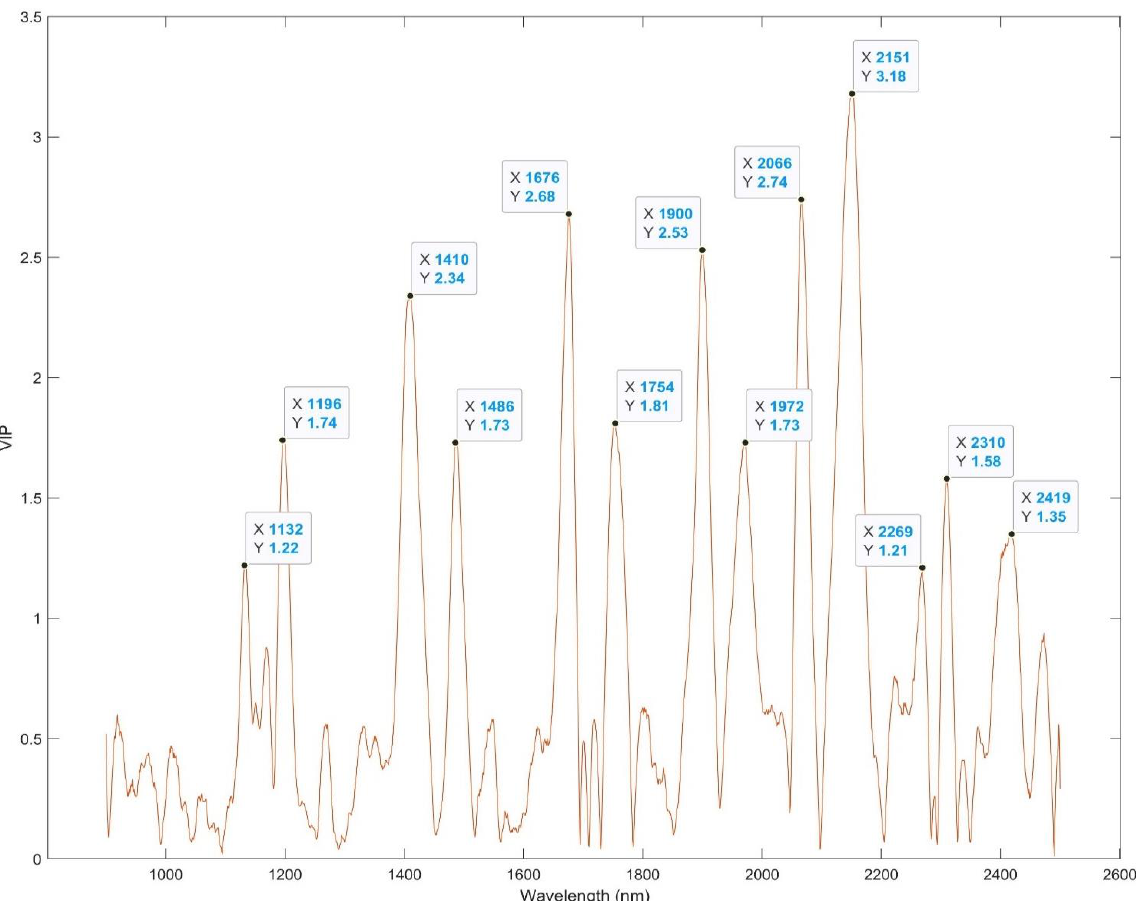
Figure 2. Variable importance in the projection (VIP) of the global protein model. X: wavelength; Y: VIP .